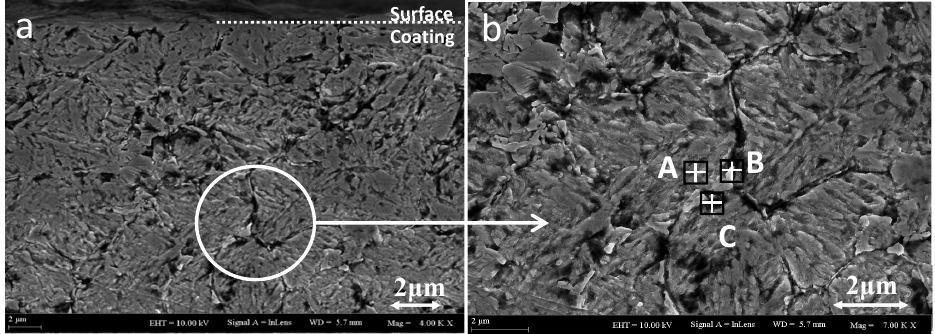
Figure 8. SEM image of plasma cladding coating after tempering: ( a ) the top region of tempered coating; ( b ) the detailed morphology. Table 2. Chemical composition of point (wt.%).